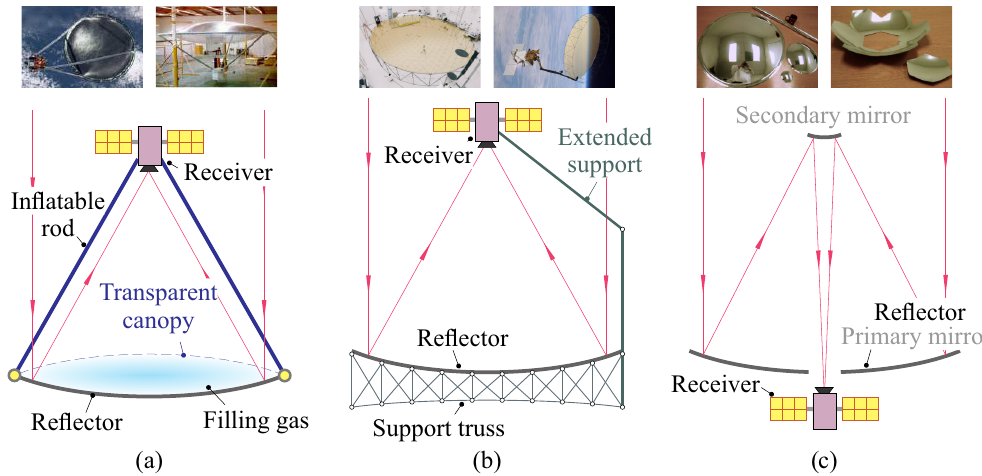
Figure 2. Three broad classes of concepts for polymer reflectors in development: ( a ) pressure stiffened membranes; ( b ) membrane antenna reflectors supported by a deployable truss mesh; ( c ) form stiffened elastic shells of a doubly curved surface. (image credits: L’Garde Inc., Northrop Grumman Corp., Mevicon Inc., and